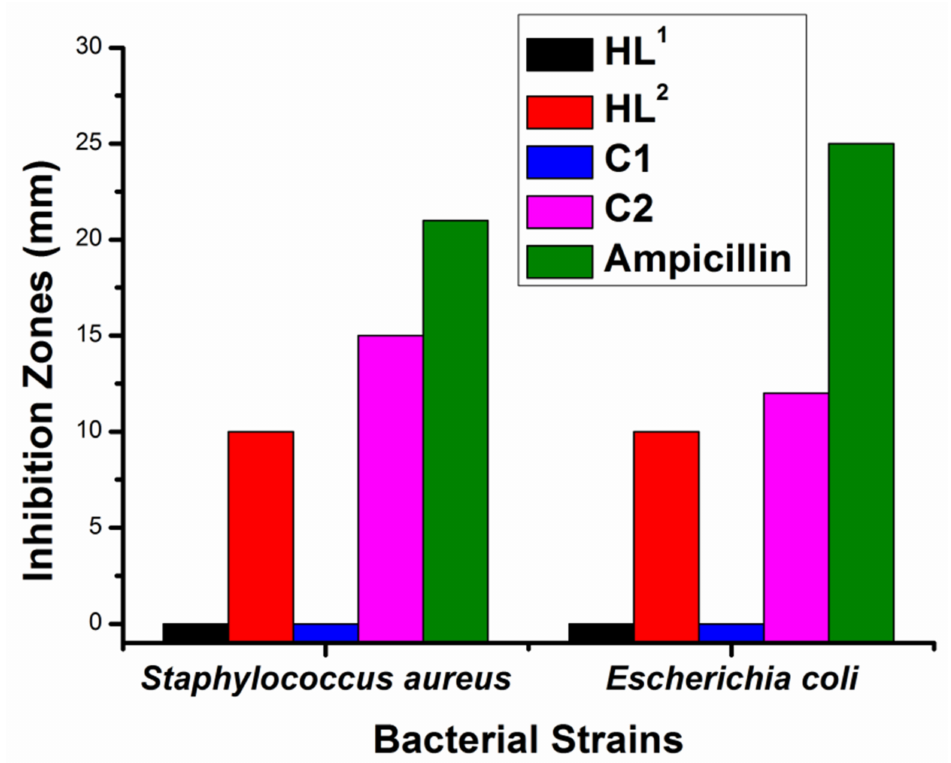
Figure 8. Correlation plot between the antibacterial activities against S. aureus and E. coli , expressed as the inhibition zone diameters in mm, and the compounds under